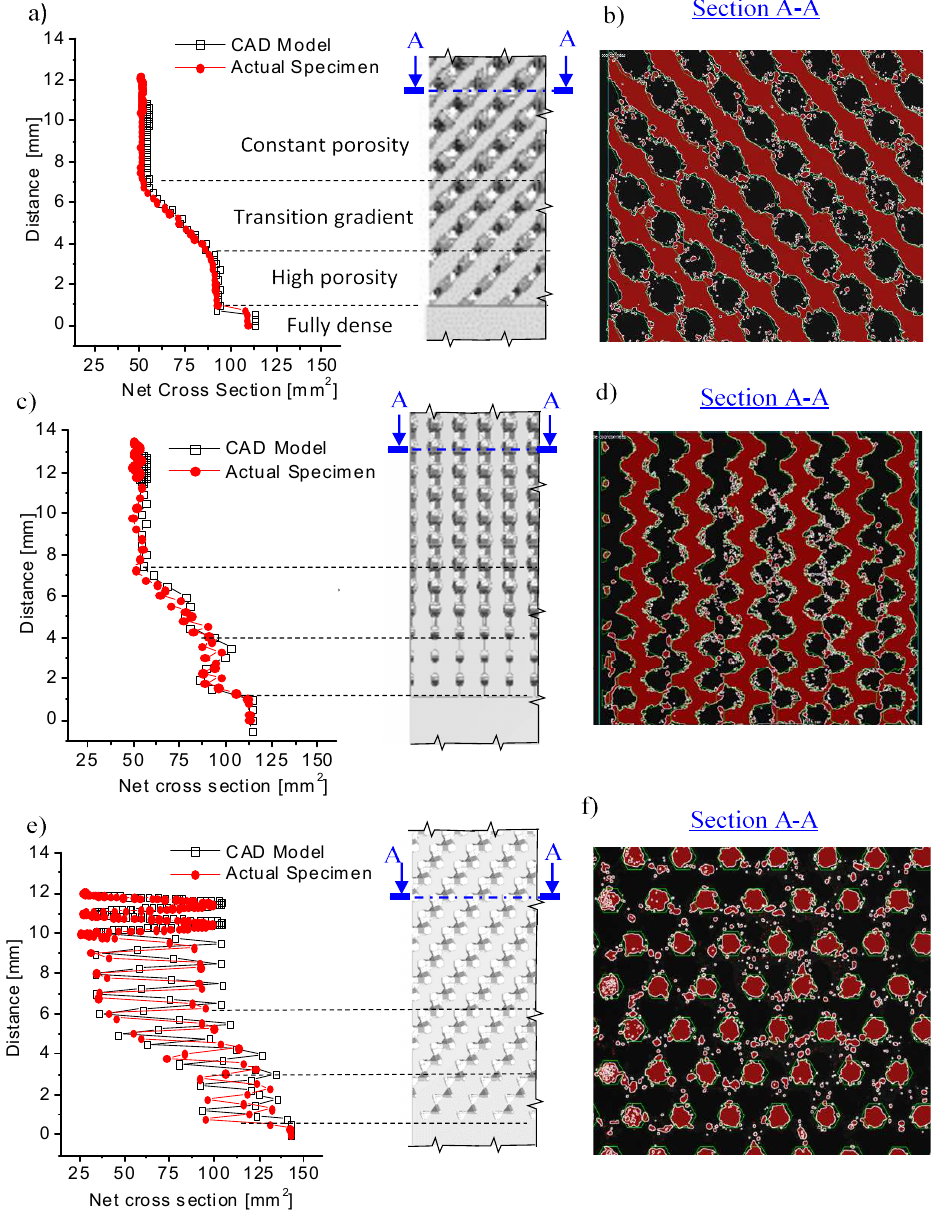
Figure 7. Evaluation of the net solid cross sections of the differently oriented lattice specimens along LD: ( a , c , e ) plots of the net solid cross sections for the three orientations; ( b , d , f ) details of the cross sections of each orientation compared with the contour lines of the CAD model.